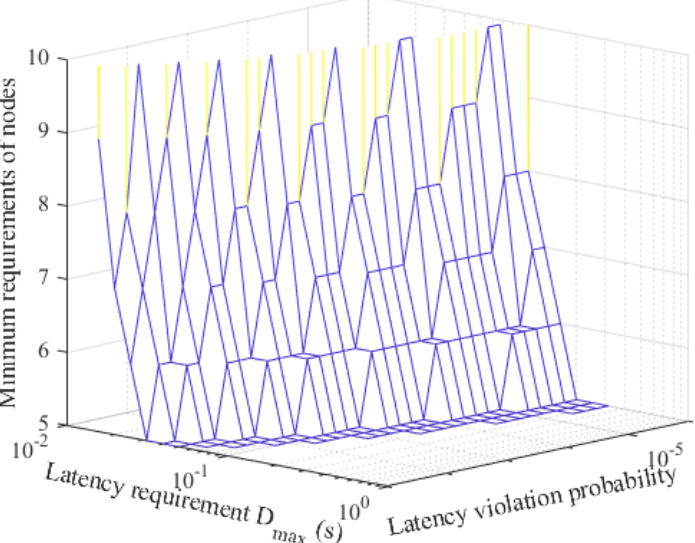
Figure 10. The minimum number requirements of nodes under different application latency require-